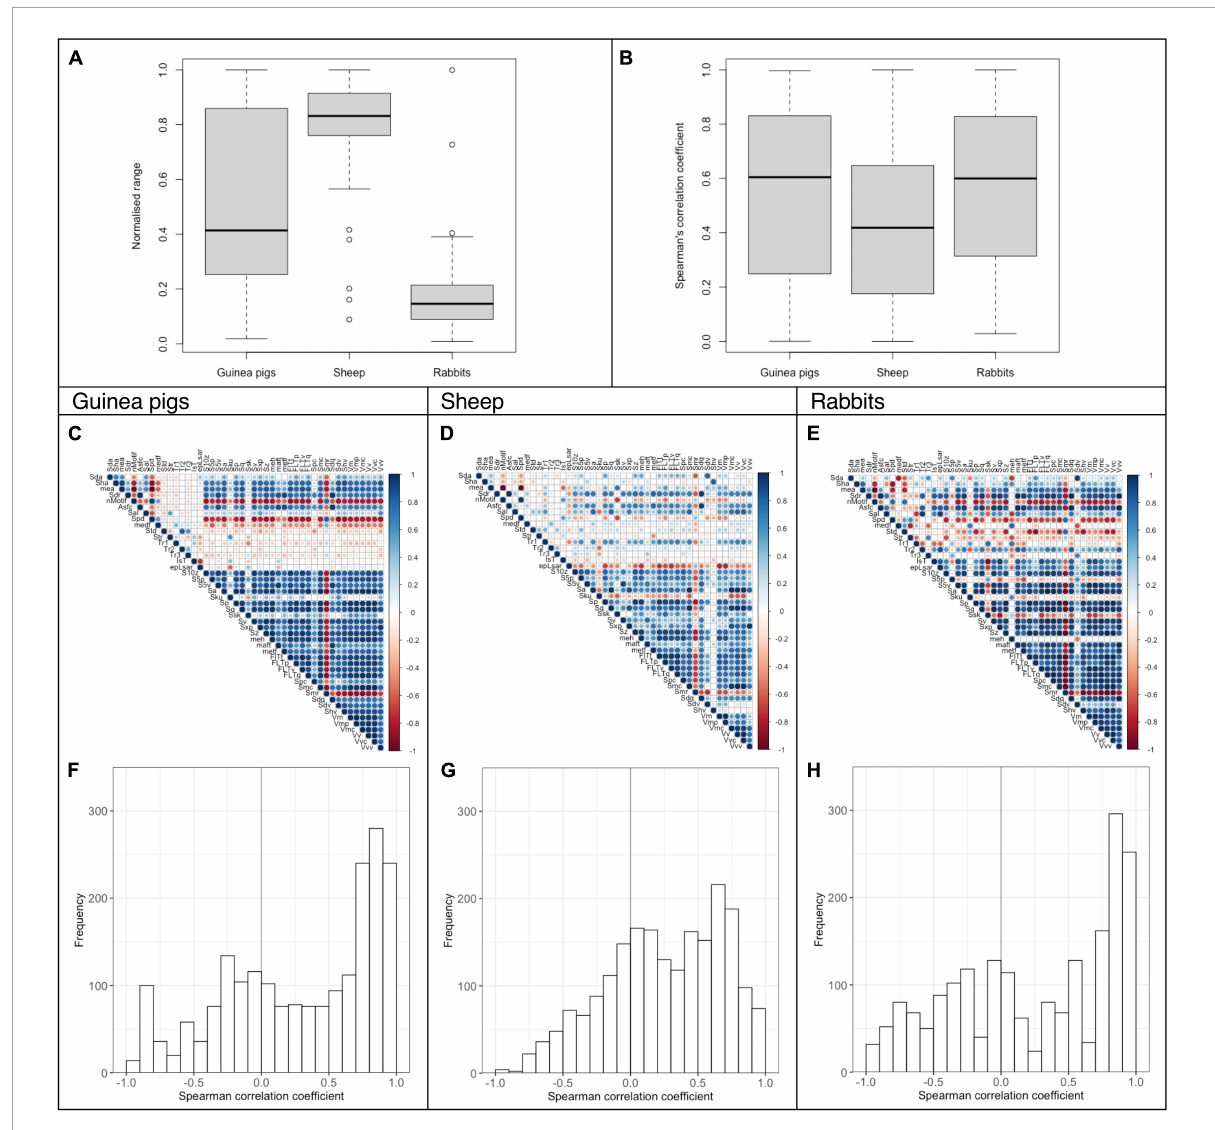
FIGURE4 Analysis of DMT parameters for guinea pigs (22 scans), sheep (19 scans) and rabbits (6 scans) fed a lucerne based pelleted diet (without any abrasive added; dataset E). The normalized data range and the Spearman’s correlation coefficients are given as boxplots (A,B) . The Spearman’s correlation of the DMT parameters is also shown as a correlation matrix (C–E) and a histogram (F–H)